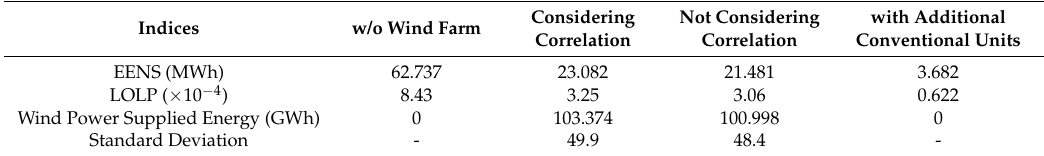
Table 4. Comparison on simulation results containing wind farms.